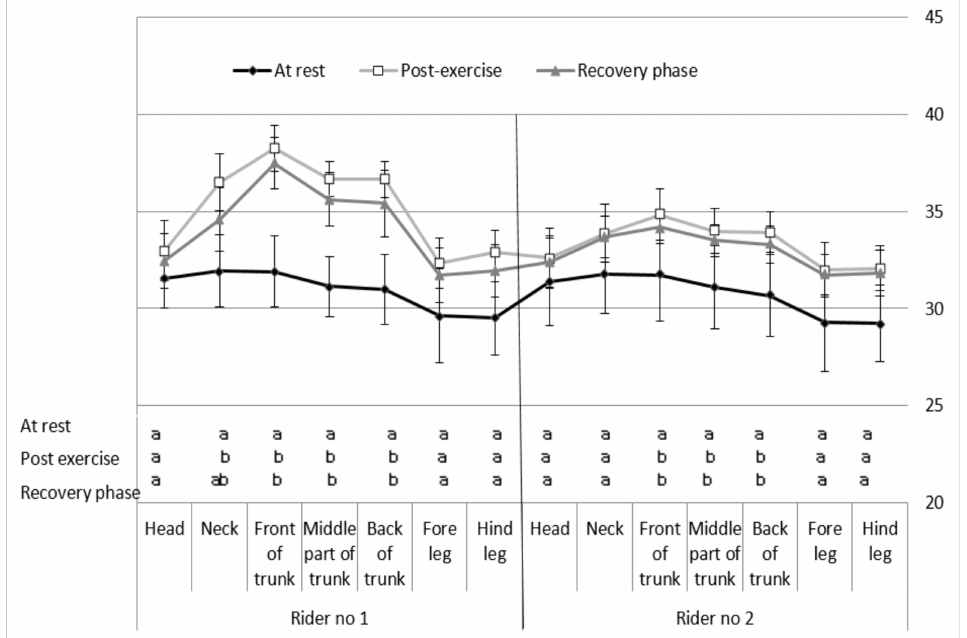
Figure 2. Average temperature ( ◦ C) of the surface on the investigated body parts of the horse recorded during subsequent stages of the trial. The means denoted with di ff erent letters di ff er significantly at p ≤